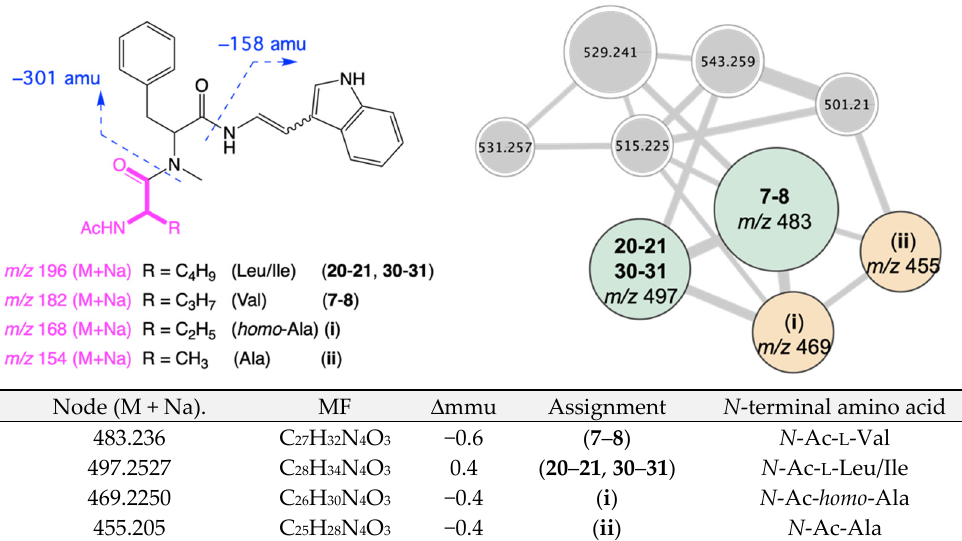
Figure 5. Known tryptamine enamino tripeptide natural products 19 – 31 . Highlighted: tryptamine enamino tripeptide scaffold (green).